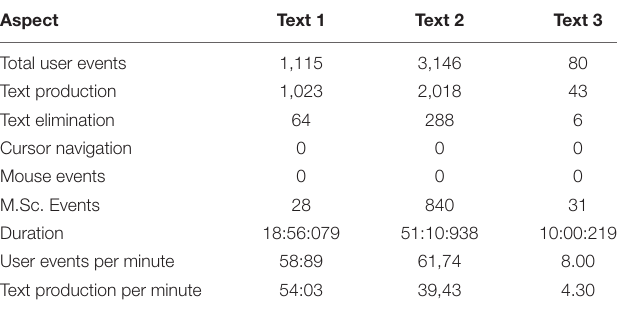
TABLE 2 | Statistics of the translation